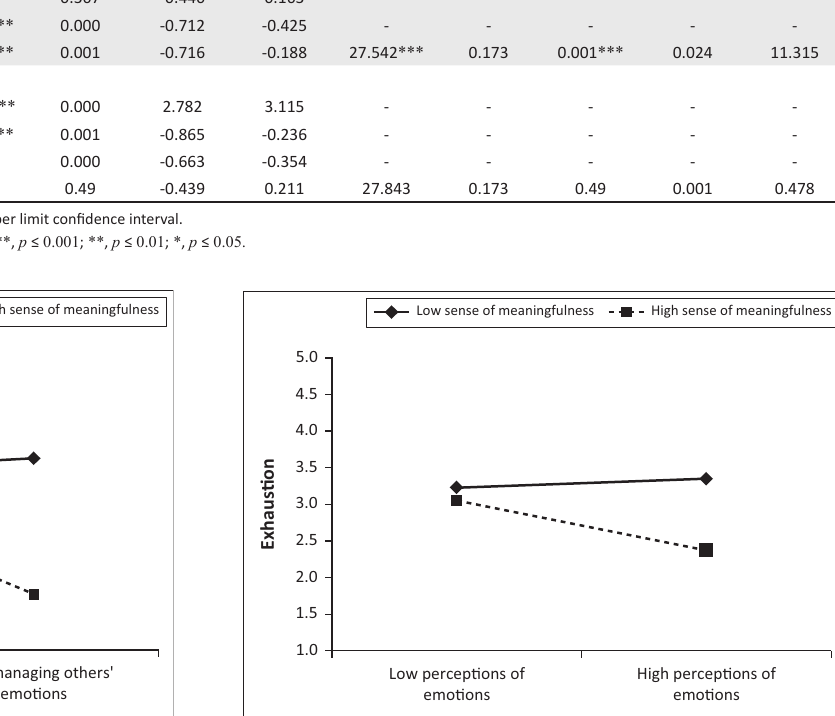
1.01.52.02.53.03.54.04.55.0